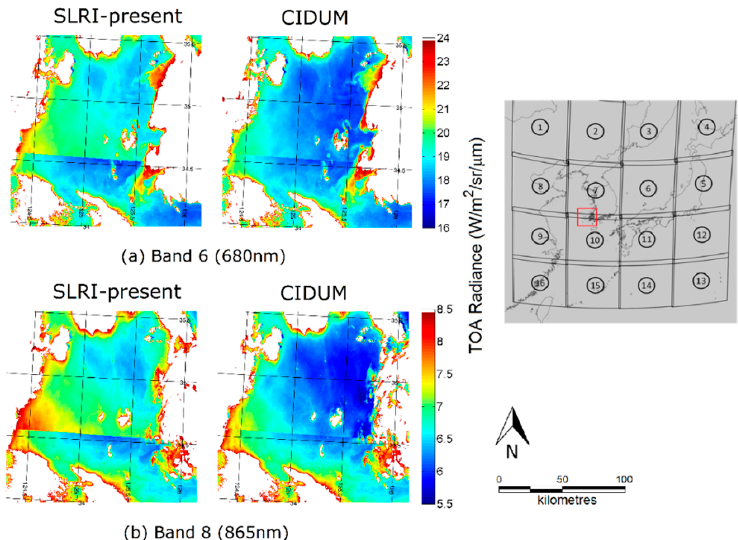
Figure 2. Images of GOCI TOA radiance acquired on October 16, 2012 (UTC 04): ( a ) Band 6; and ( b ) Band 8, both before and after the CIDUM correction. The location of the image area is marked in the slot area image of GOCI L1B data on the right.